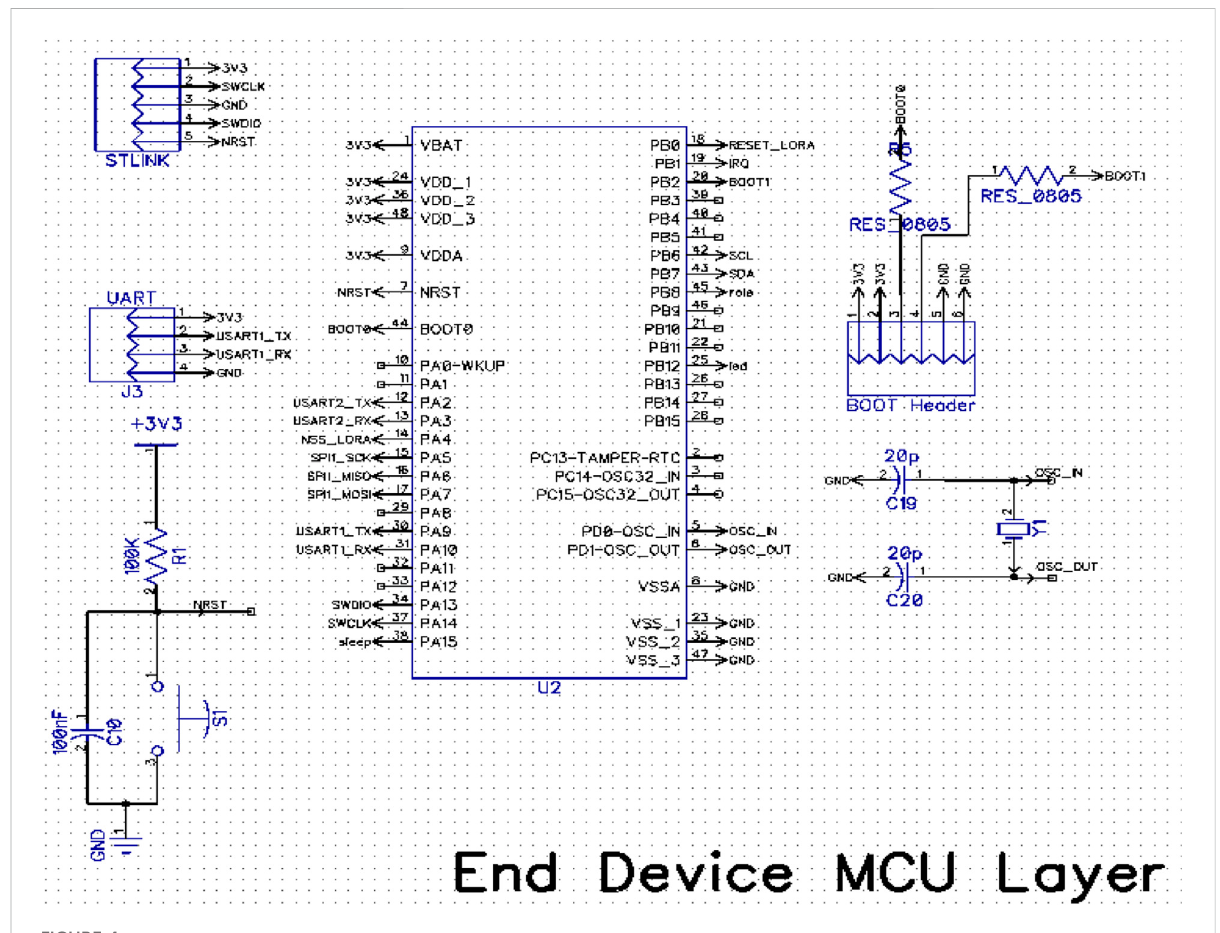
FIGURE 4 Schematic diagram of the end device ’ s MCU